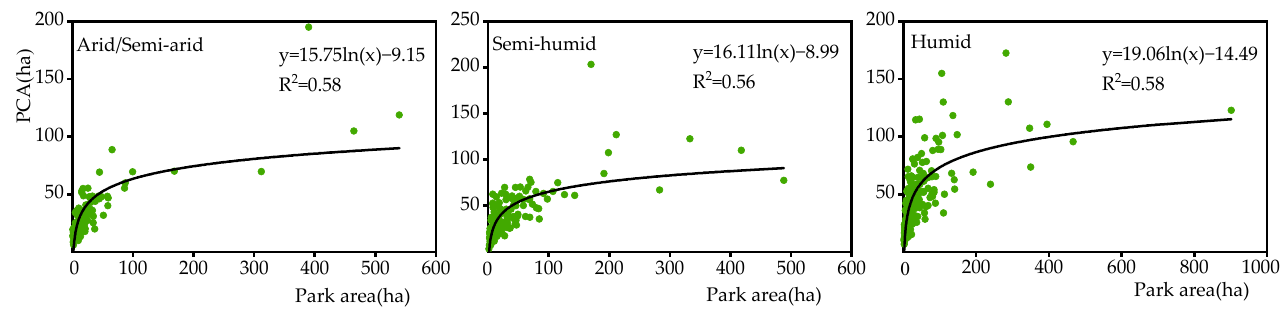
Figure 10. Relationship between PCA and park area in three climatic regions.